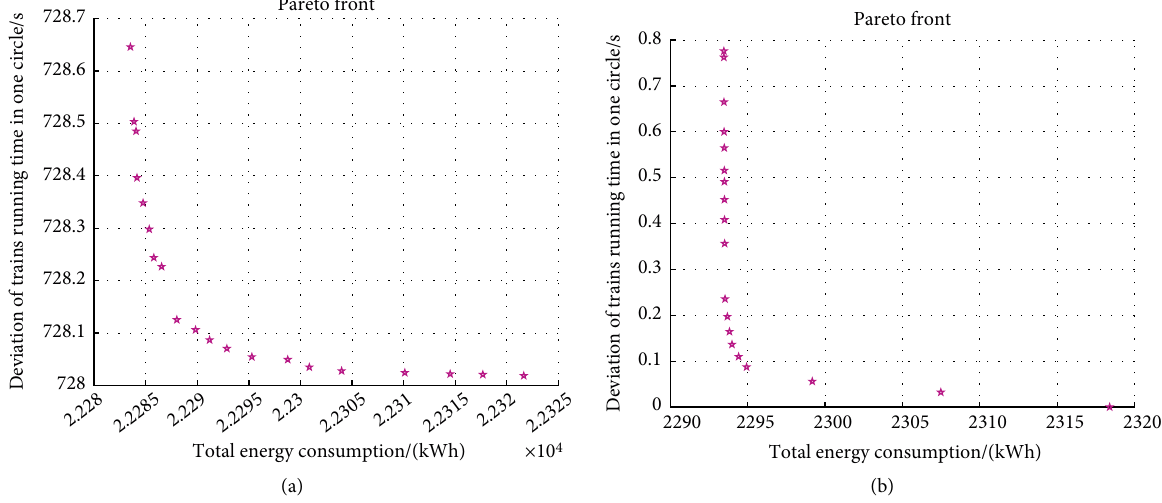
Figure 18: The Pareto front under and OIC = 0.2. (a) The Pareto solutions of the OEST. (b) The Pareto solutions of the OQOST. 𝐺 = 200